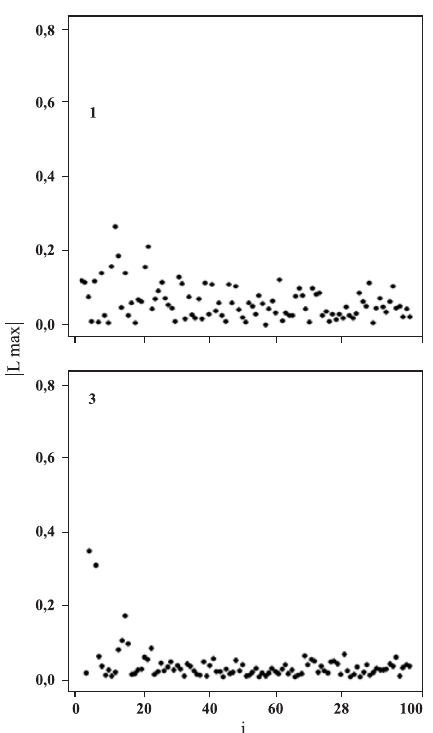
| for simulated data Figure 7. Index plot of |L max using the Matérn 0-10-10 (left side) and 0-10-15 (right side) covariance function, with k = 3.0.